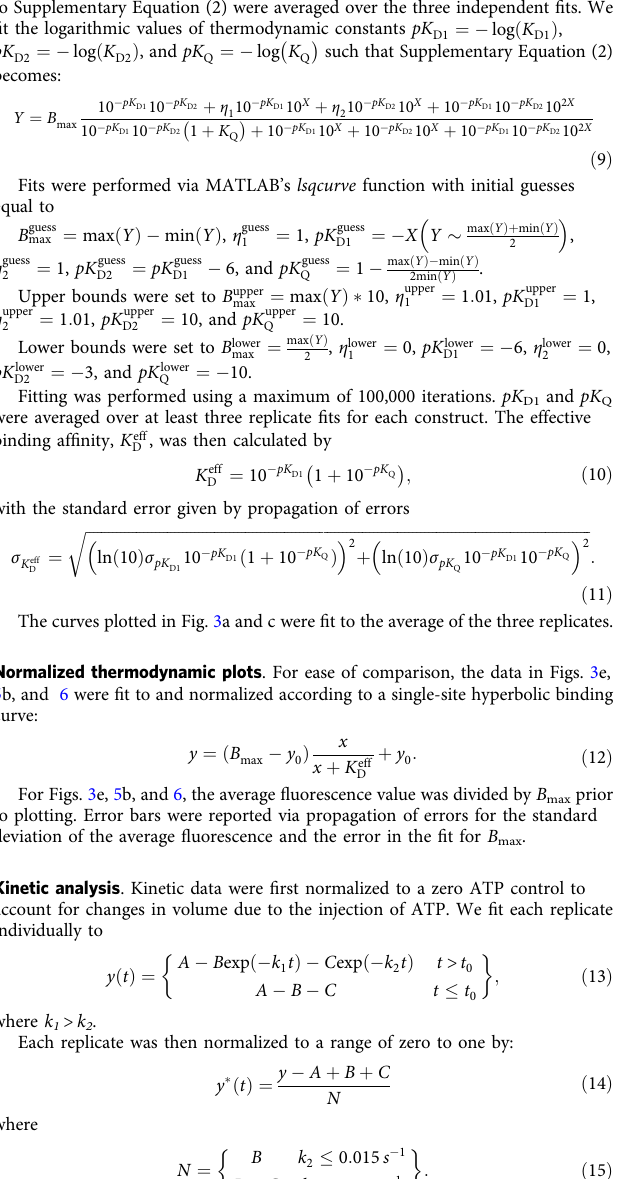
Measurements of binding kinetics . ISD constructs of varying linker and dis- placement strand lengths were suspended at a concentration of 333.3 nM in a 30 μ